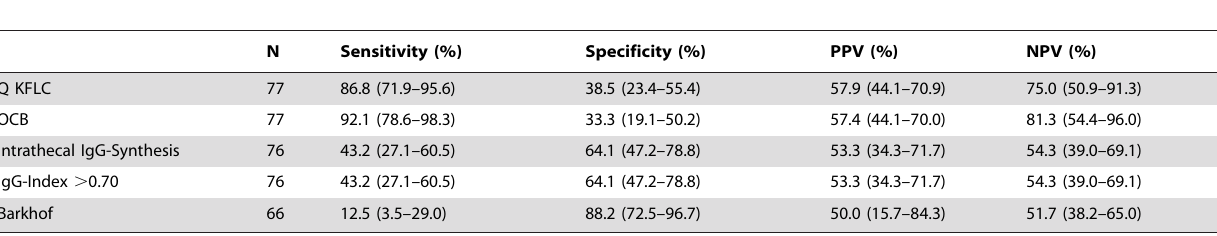
Table 3. Sensitivity, specificity, positive and negative predictive value for elevated KFLC, MRI parameters and OCB regarding conversion of clinically isolate syndrome to definite multiple